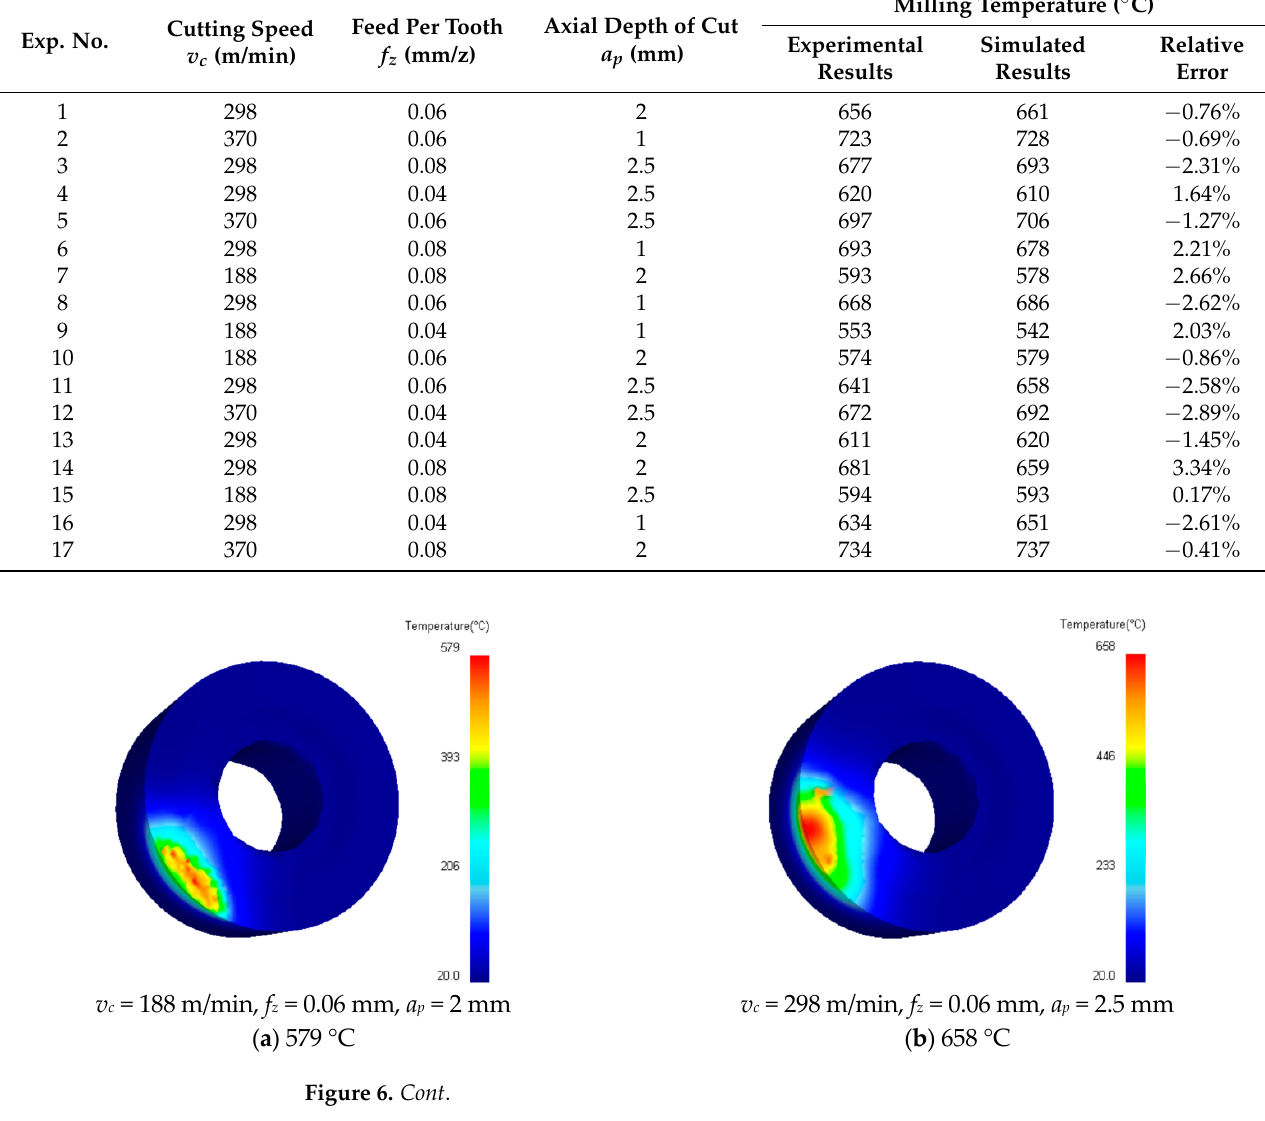
Table 4. Simulated and experimental results. Table 3. Relevant parameters of the J-C model .